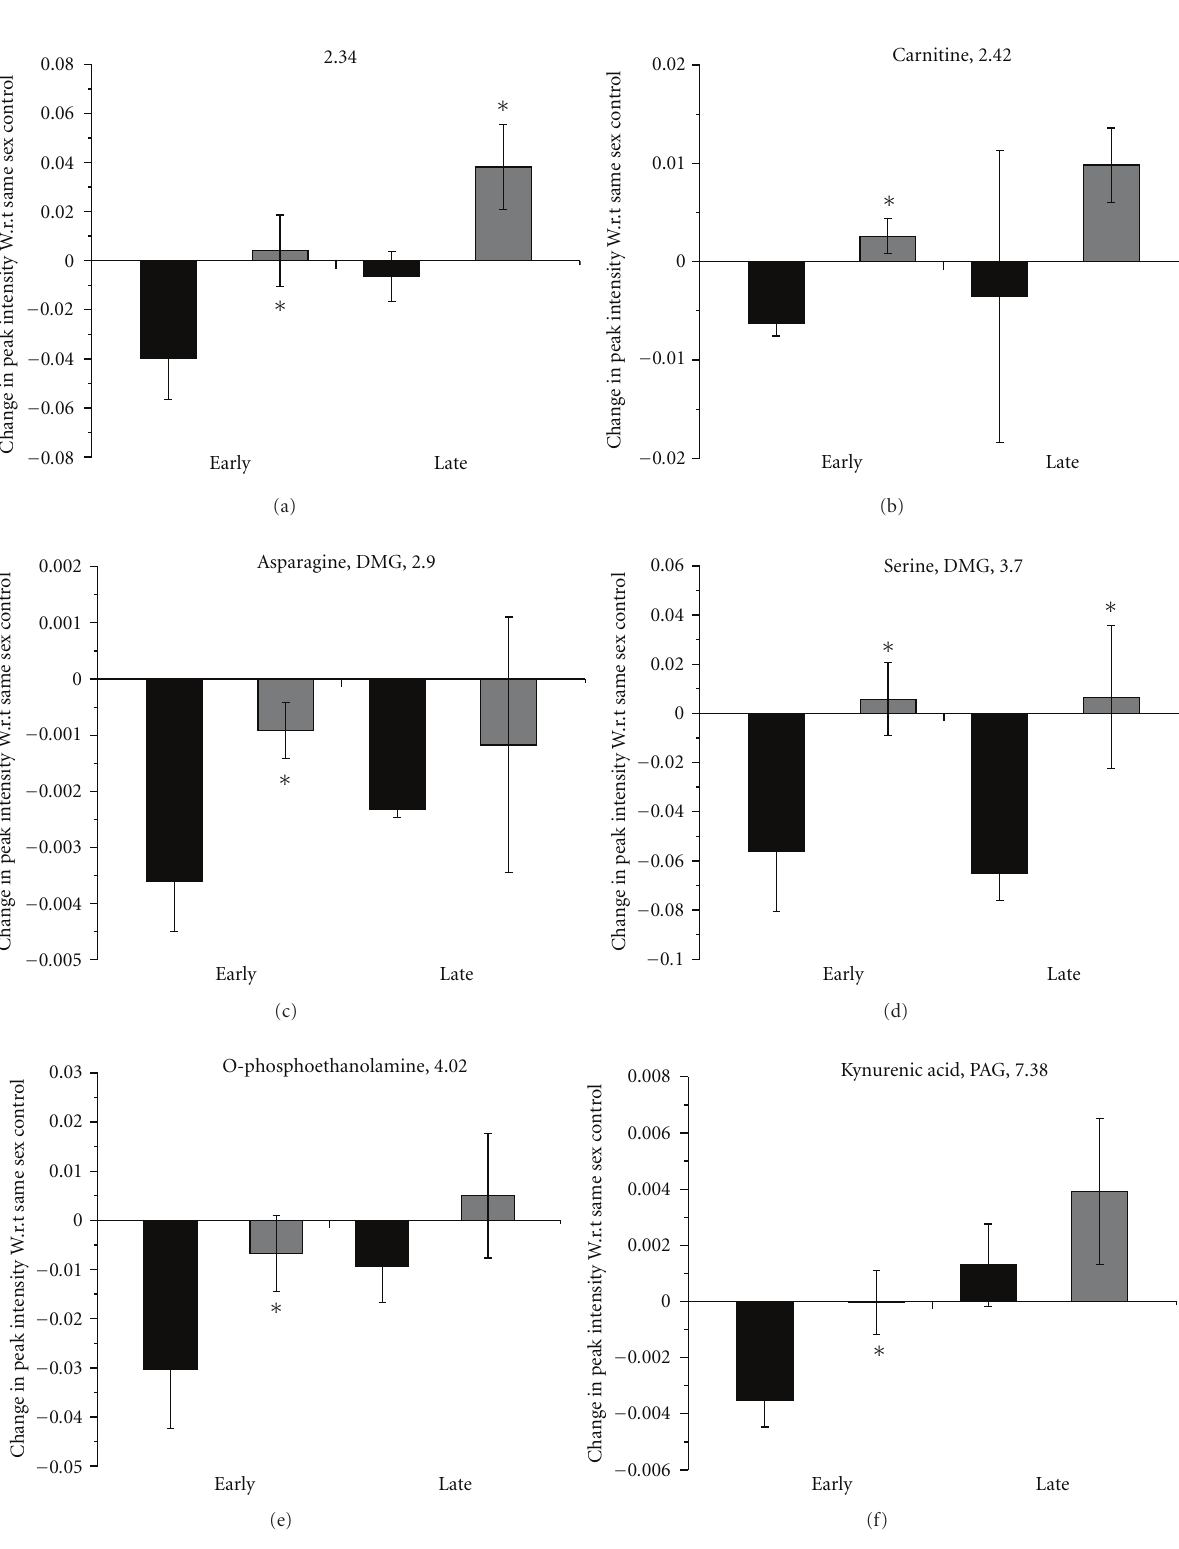
Figure 3: Perturbed metabolite levels in mouse liver at early- and late-stage malarial infection: comparison of e ff ects in male and female animals. The average peak intensity for the metabolite in uninfected samples of the same sex was subtracted from individual peak intensities of infected animals at each stage of infection. The average change in intensity with respect to the same sex control is plotted here. ∗ indicates P < . 05, + indicates P < . 08 in comparison to the males at each stage. Black = male, and grey = female. Panels showing two metabolites represent overlapping 1 H NMR resonances at the chemical shift mentioned. Where only chemical shifts are mentioned, identity of metabolites could not be